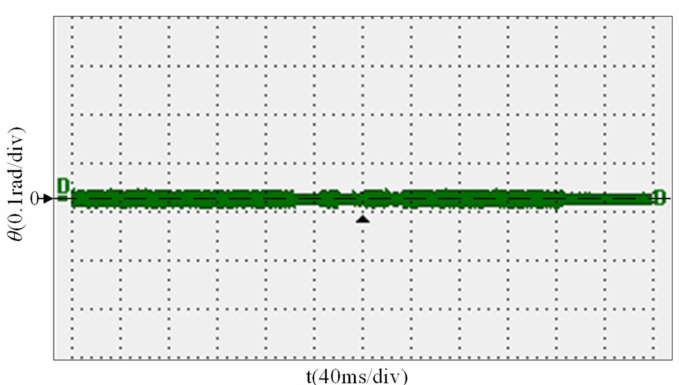
Figure 31. Rotor position error waveform at the sudden change of rotation